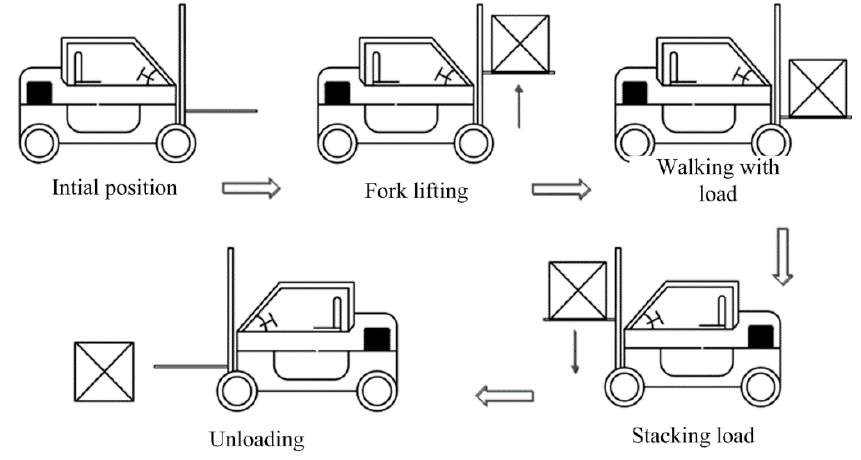
Figure 3. Flow chart of the operation cycle of a forklift.